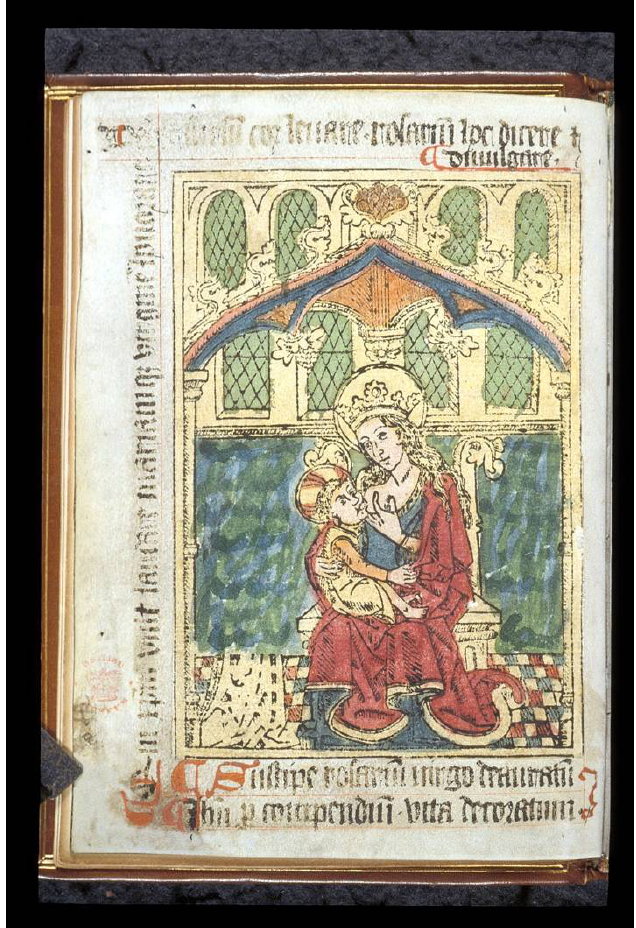
Figure 9. A woodcut showing the virgin suckling her child forms the entrance to the passion devotion of the book. Devotion to the bleeding body of Christ is folded into Marian devotion. MS Egerton 1821, fol. 2v. British Library, London.